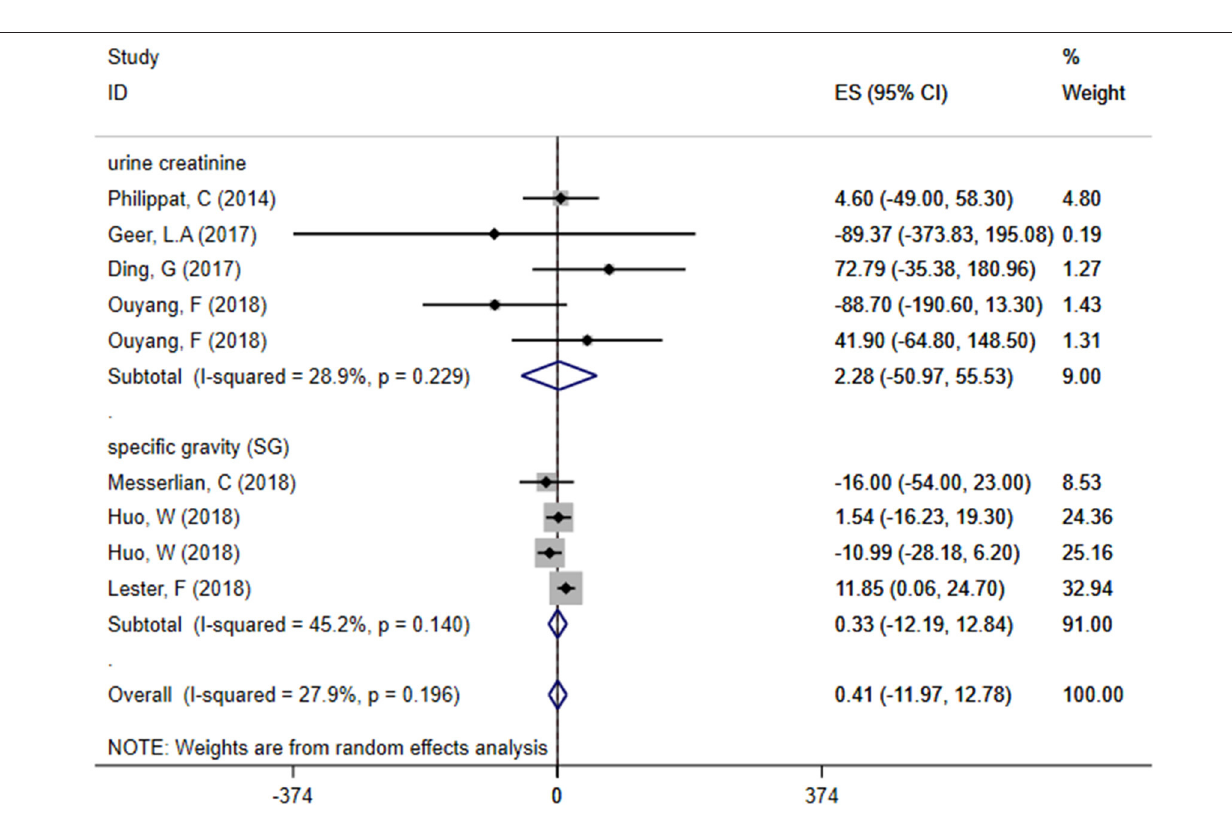
FIGURE 5 | Subgroup analysis of different adjusted methods of TCS in TCS exposure on neonatal birth